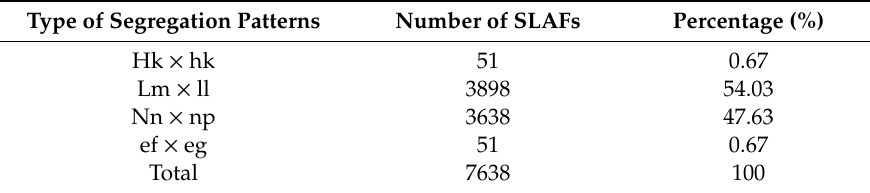
Table 2. The number of SLAFs in di ff erent types of segregation patterns for map